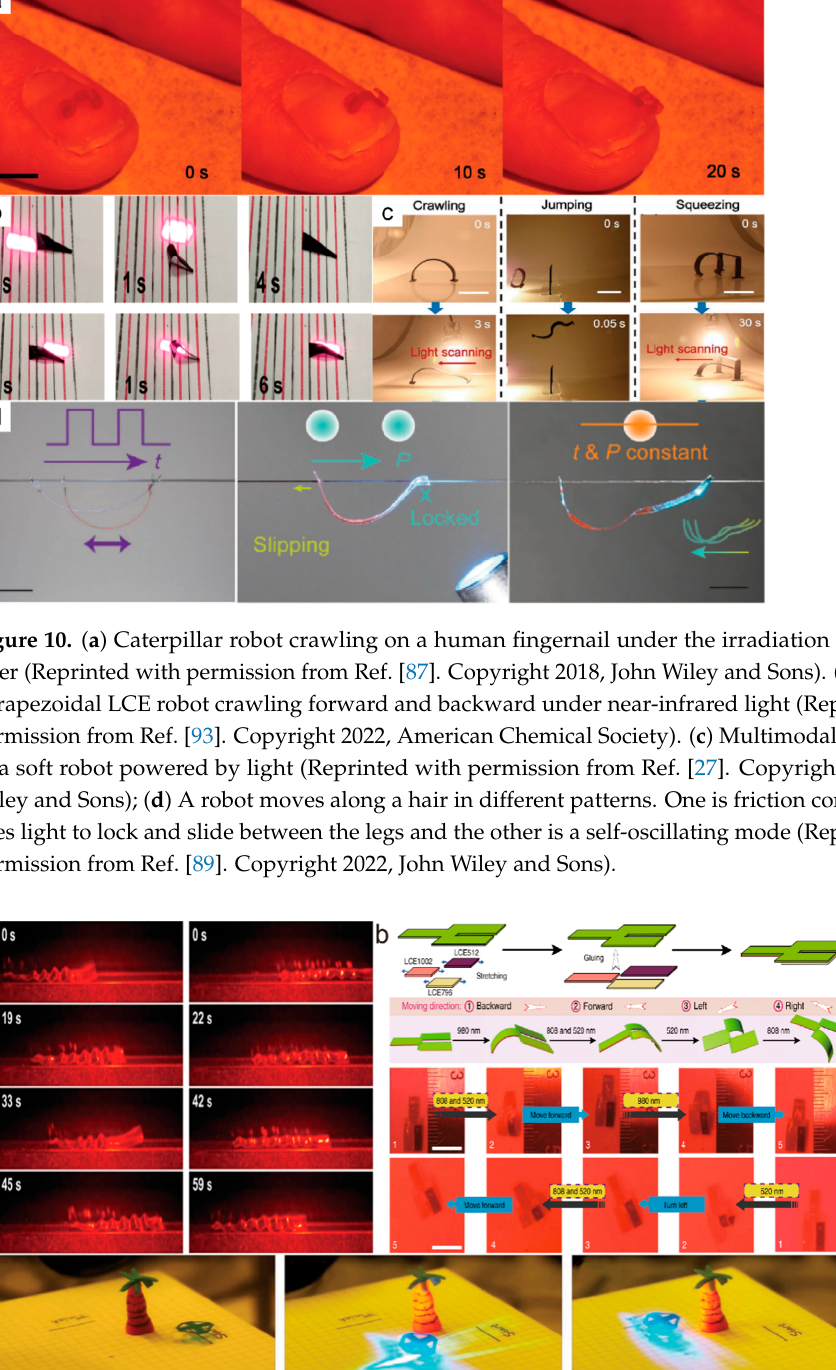
Figure 10. ( a ) Caterpillar robot crawling on a human fingernail under the irradiation of a 488 nm laser (Reprinted with permission from Ref. [87]. Copyright 2018, John Wiley and Sons). ( b ) Image of a trapezoidal LCE robot crawling forward and backward under near-infrared light (Reprinted with permission from Ref. [93]. Copyright 2022, American Chemical Society). ( c ) Multimodal locomotion of a soft robot powered by light (Reprinted with permission from Ref. [27]. Copyright 2019, John Wiley and Sons); ( d ) A robot moves along a hair in different patterns. One is friction control, which uses light to lock and slide between the legs and the other is a self-oscillating mode (Reprinted with permission from Ref. [89]. Copyright 2022, John Wiley and Sons).